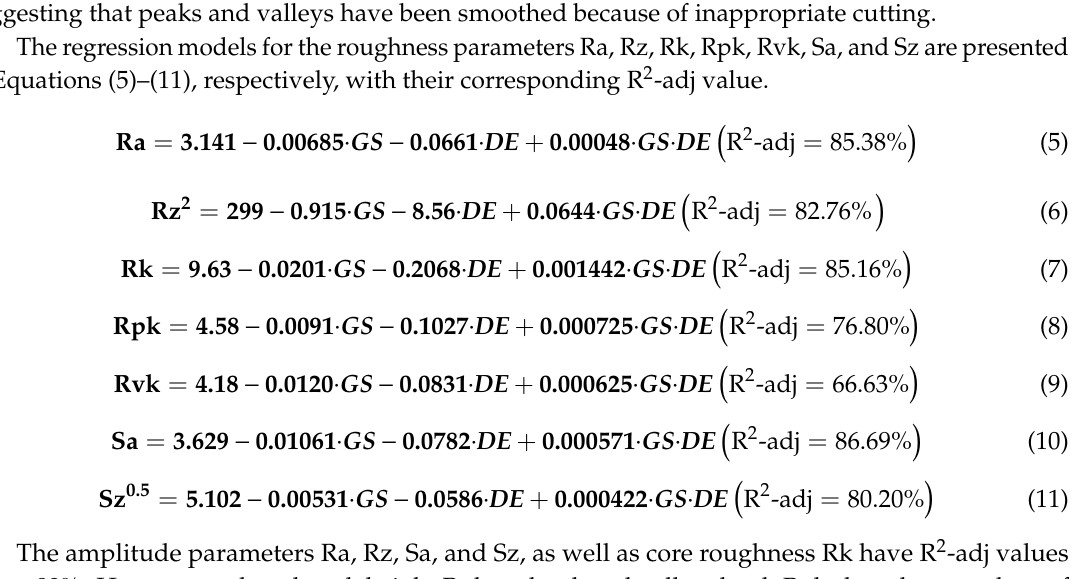
Figure 3. Magnified image of the abrasives’ surfaces of: ( a ) Experiment 2 and ( b ) Experiment 7. In Figure 3a, performed with grain size 181 and density 45 (experiment 2), sharp abrasive grains are observed. The bond surface shows several marks produced by the detached grains during the honing operation. This corresponds to a correct honing operation. On the contrary, Figure 3b shows a picture of the abrasive with grain size 91 and density of abrasive 60 (experiment 7). There, a more irregular surface is seen, in which abrasive grains are not clearly observed. Some grains are worn out, with smooth surfaces, and only few marks of detached grains are detected on the abrasive’s surface. This suggests that, due to the high density of abrasive, most grains crush the workpiece material rather than cutting it, and the chips fill the voids, leading to clogging. 3.2. Material Removal Rate and Tool Wear Results for material removal rate Qm (cm/min) and tool wear Qp (cm 3 /min) are presented in Table 3 for all experiments considered.